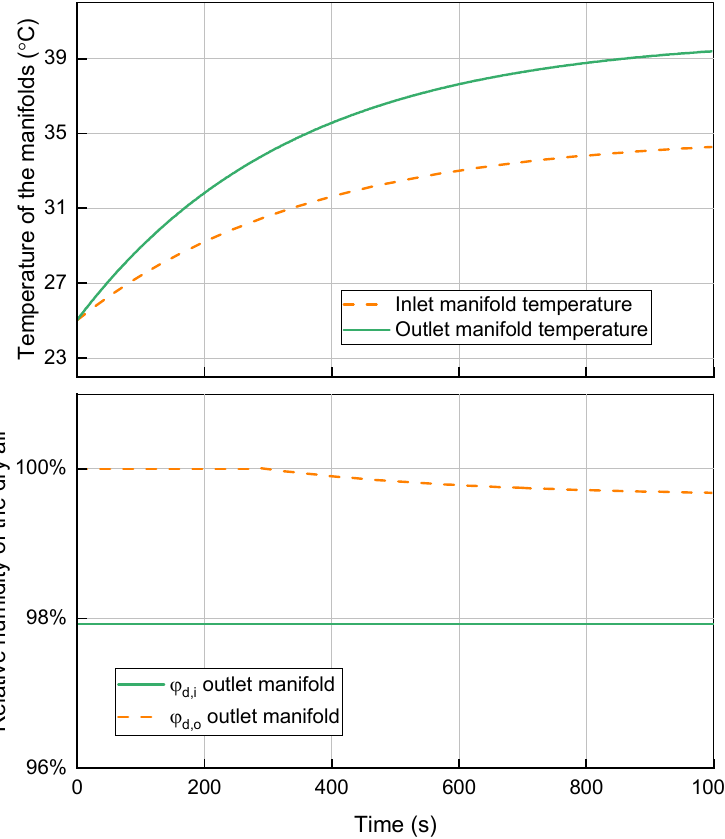
Figure 9. Effects of long-term operating conditions and possible water saturation in the outlet manifold.